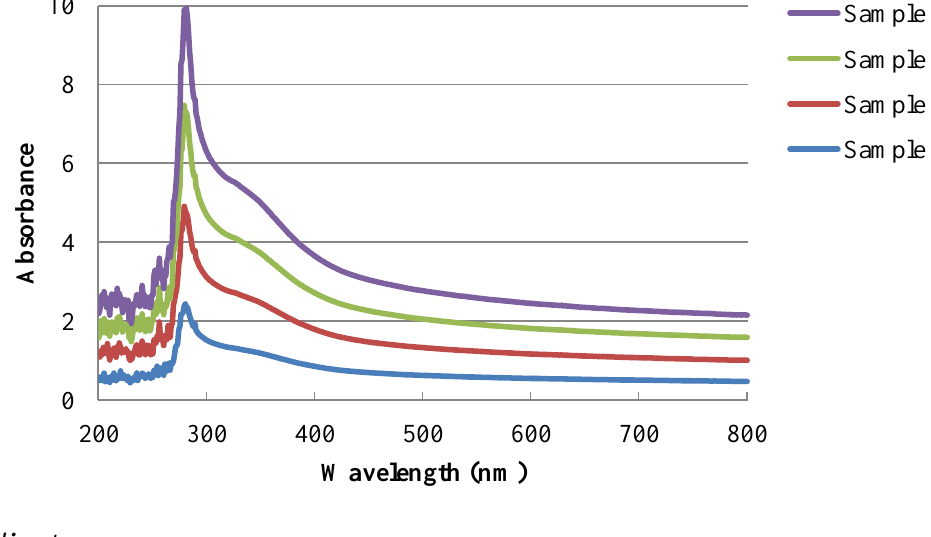
Figure 3. The UV-Vis spectra for samples #1 to #4 containing 10 mg of AIBN, 1.5 mL